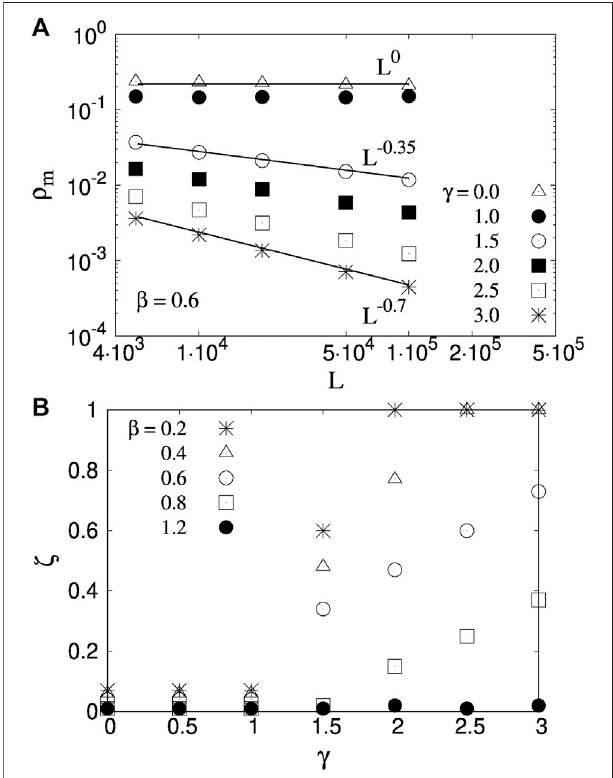
FIGURE 7 | (A) System size effect of ρ m for β (cid:1) 0.6 and c between 0 and 3.Weobserve ρ m ∼ L − ζ ,where ζ isanincreasingfunctionof c . (B) Variationof ζ with c for 0.2 ≤ β ≤ 1.2. For low c , ζ ≈ 0 independent of β . For high c , on the other hand, ζ (cid:1) 1 depending on whether β is low enough or